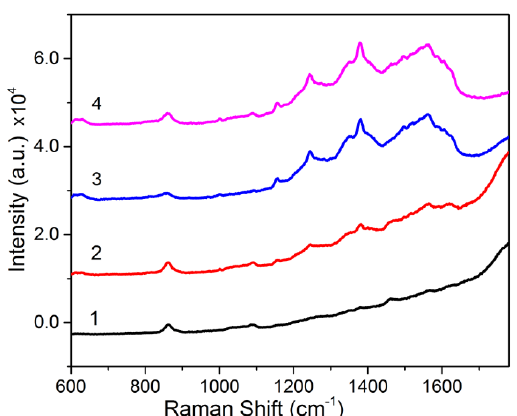
Figure 3. Surface-enhanced Raman scattering (SERS) spectra of melanin–Ag nanocomposites prepared with different volumes of silver–ammonia complex under 514.5 nm excitation: (1) 100μL; (2) 200μL; (3) 300μL; (4) 400 μL.